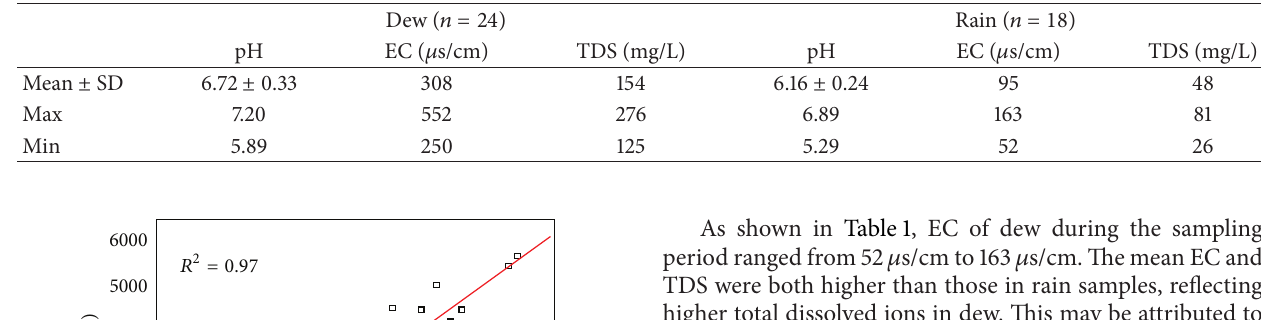
Table 1: Summary of pH, electrical conductivity (EC), and total dissolved solids (TDS) of dew ( 𝑛 = 24 ) and rainwater samples ( 𝑛 = 18 ) collected over Changchun city during the experimental period in 2013 and 2014.